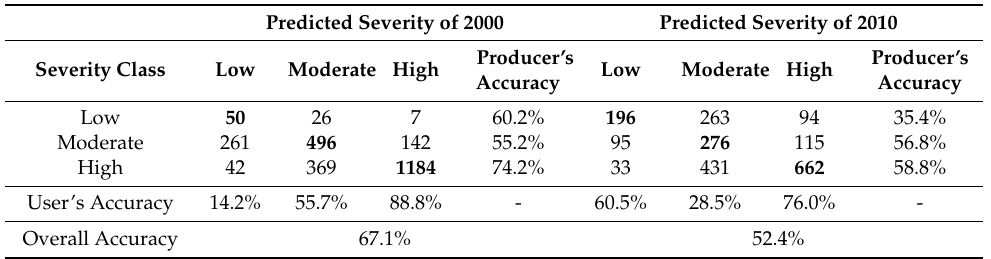
Figure 3. Two examples of linear relationships used for validating model performance of 2000 ( a , c ) and 2010 ( b , d ) based on 200 training samples ( a , b ) and 100 verification samples ( c , d ). Coefficients of determination ( R 2 for training samples), and the squared multiple correlation coefficients ( r 2 for verification samples) are also plotted. Blue solid lines show predicted linear regression fit. Black dashed lines represent 1:1 line. Table 3. Accuracy assessment of predicted fire severity classification for fire year 2000 and 2010, respectively.